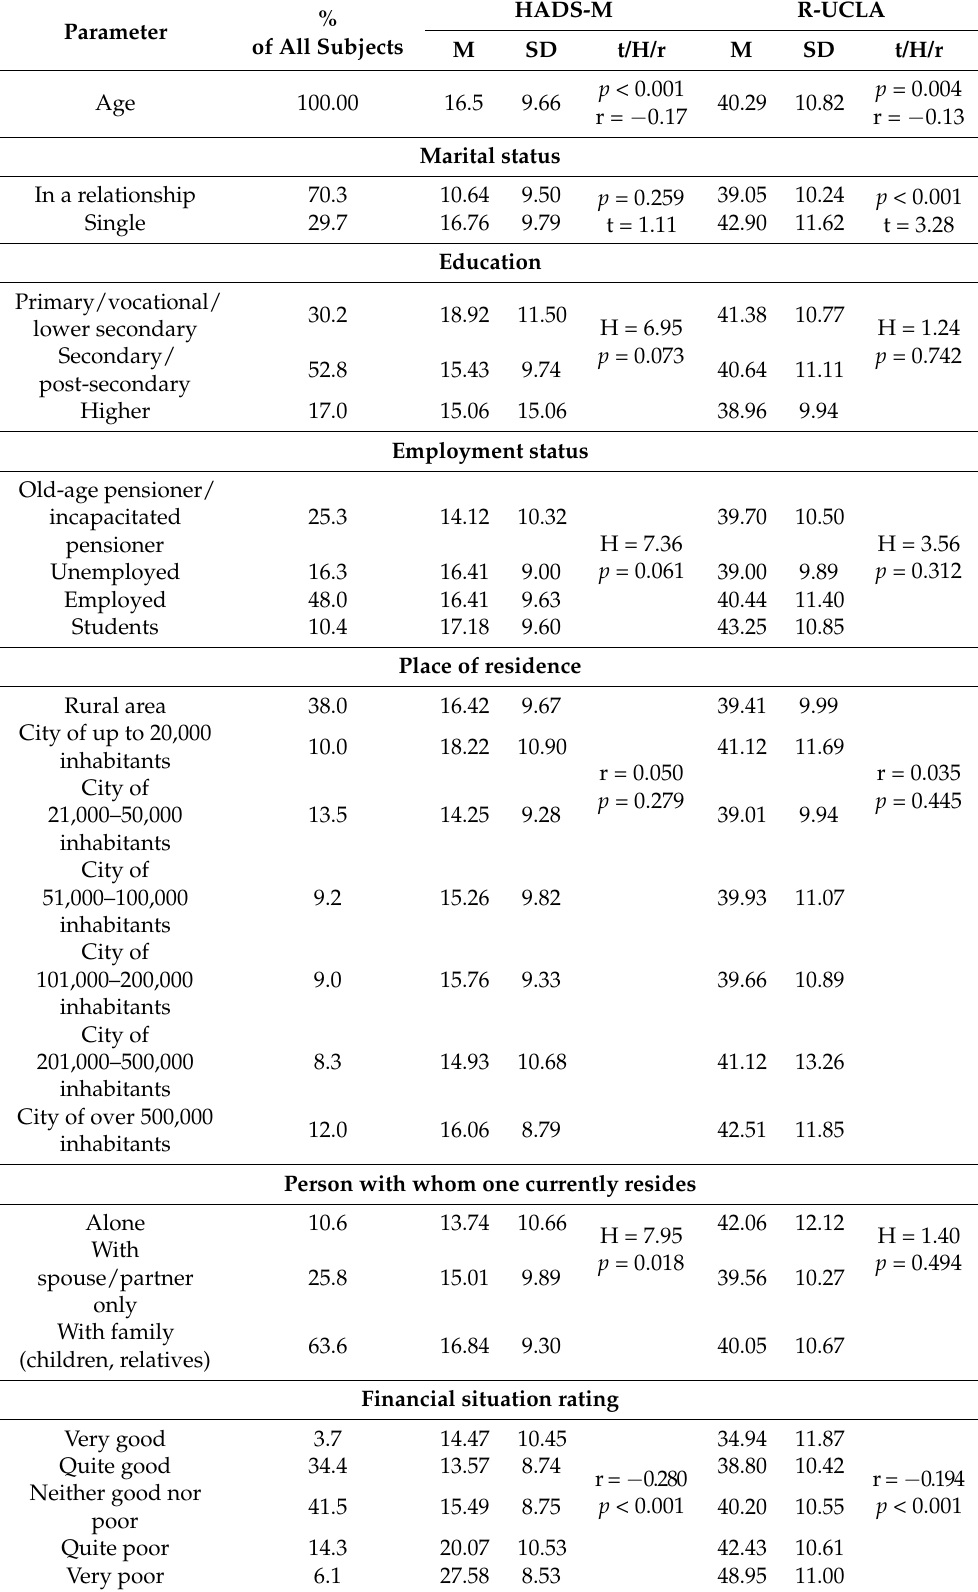
Table 4. Sociodemographic variables with regard to HADS-M and R-UCLA scores.